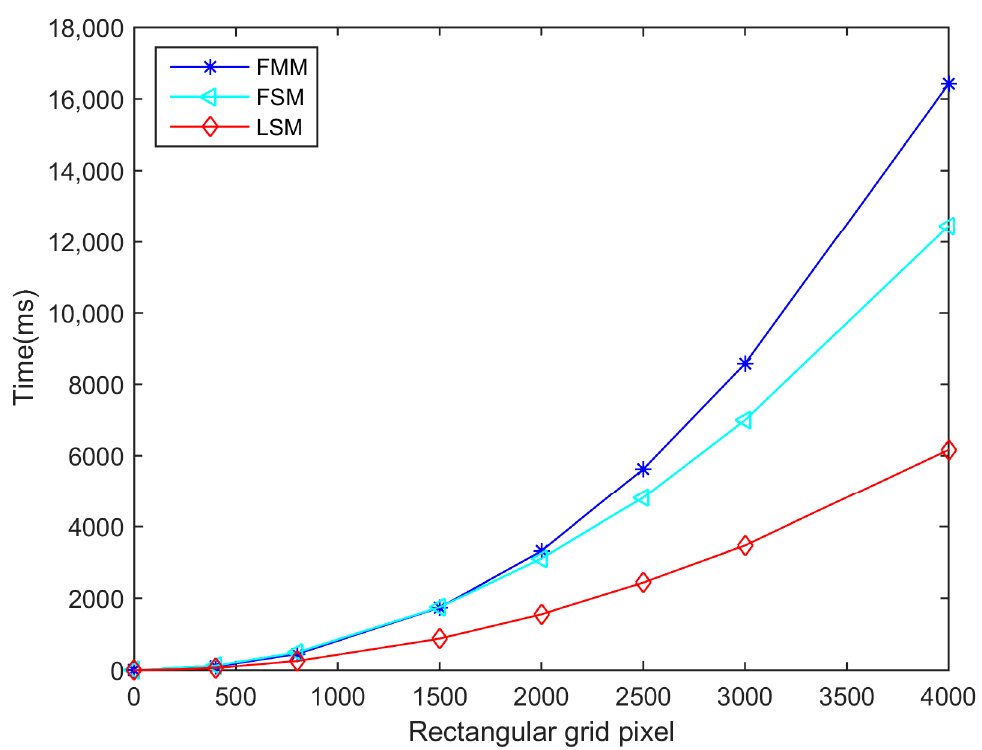
Figure 21. Computation times for the marine